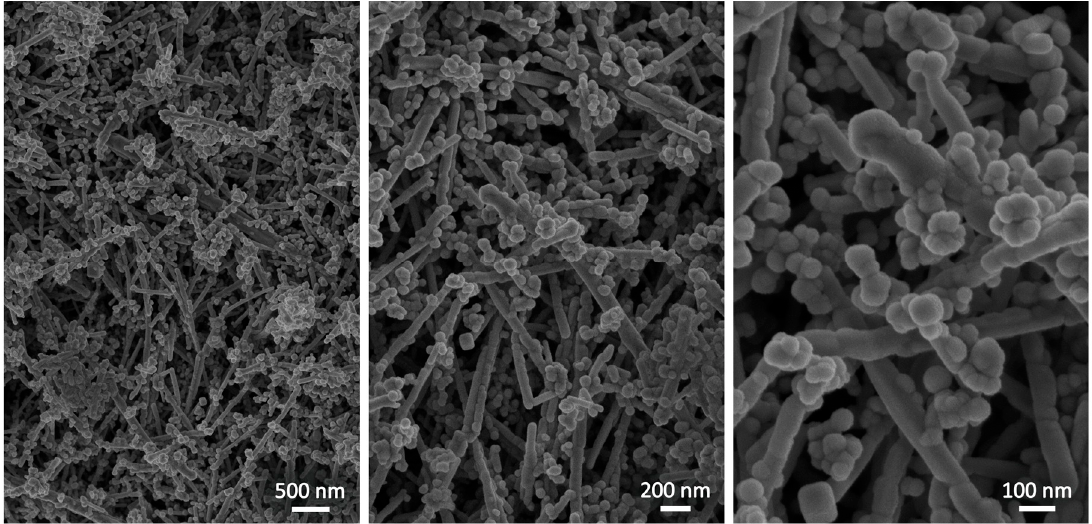
Figure 3. EDX maps of the Ce50Pr50 catalyst showing the distribution of Ce and Pr ions. Figure 2. FESEM images of the Ce50Pr50 catalyst. Figure 2. FESEM images of the Ce50Pr50 catalyst.